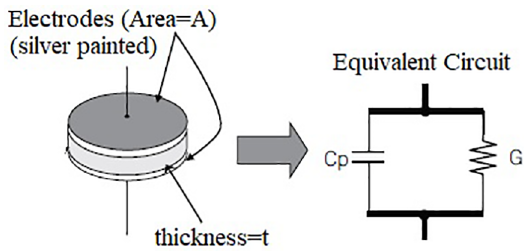
Figure 2. The equivalent circuit of dielectric measurement of round disc CaCO